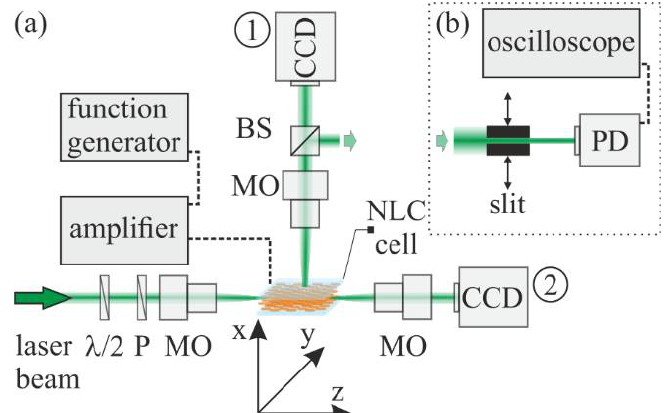
Figure 2. Sketch of the experimental setup showing: ( a ) part devoted to beam coupling and visualization of the beam propagation; ( b ) part for determining waveguide formation times. λ/2—halfwave plate, P—polarizer, MO—microscope objective, BS—beam splitter, CCD—digital camera, PD—photodiode.